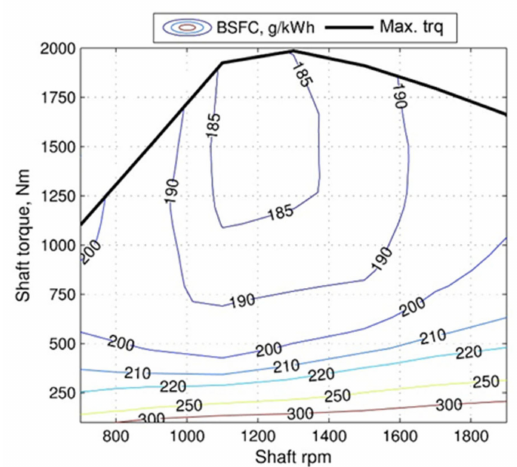
Figure 3. Brake-specific fuel consumption (BSFC) map of the diesel engine.